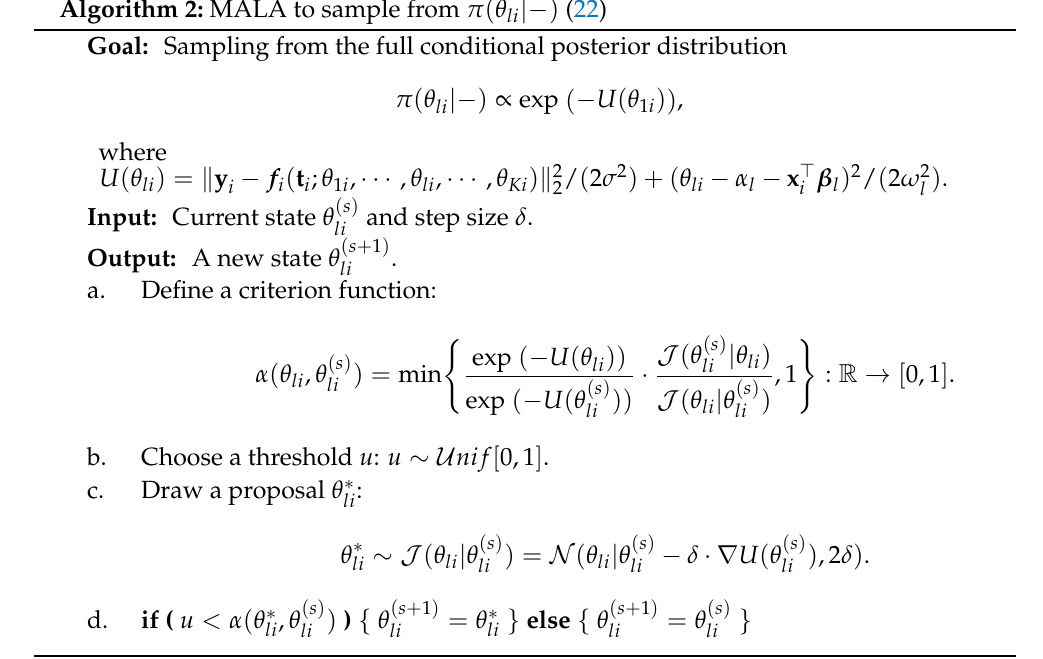
Algorithm 2: MALA to sample from π ( θ li |− ) (22) Goal: Sampling from the full conditional posterior